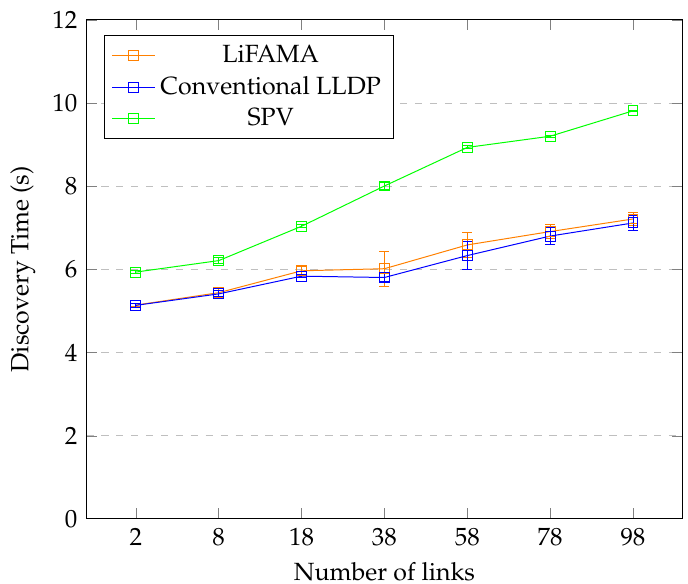
Figure 12. Linear topology